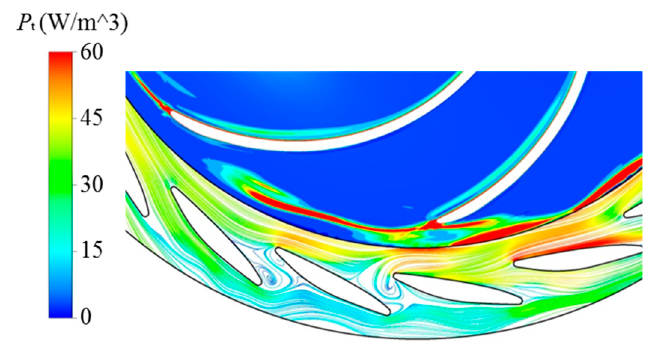
Figure 25. Instantaneous distributions of turbulent kinetic energy dissipation in the impeller and streamlines in guide vane channels at condition V.